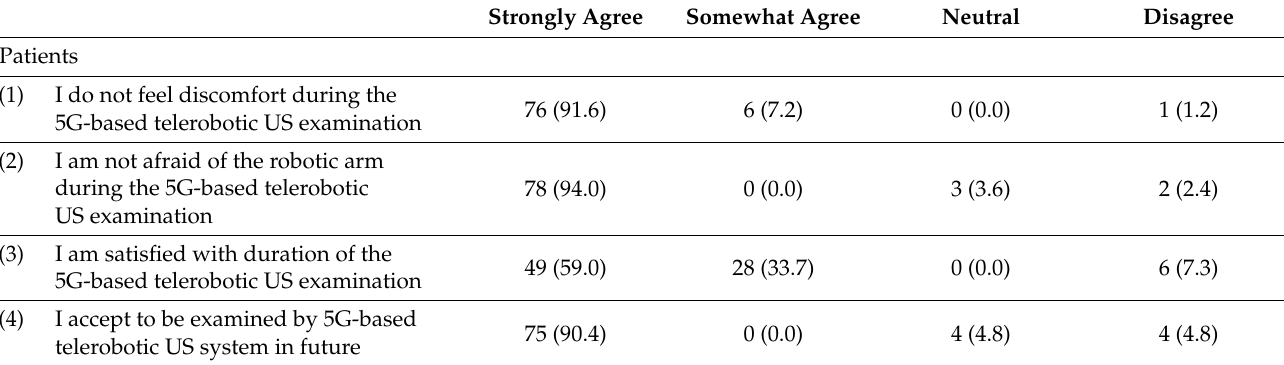
Table 6. Answers of patients and tele-sonologists to the questionnaires in the two Scenarios. Except where indicated, data in parentheses are